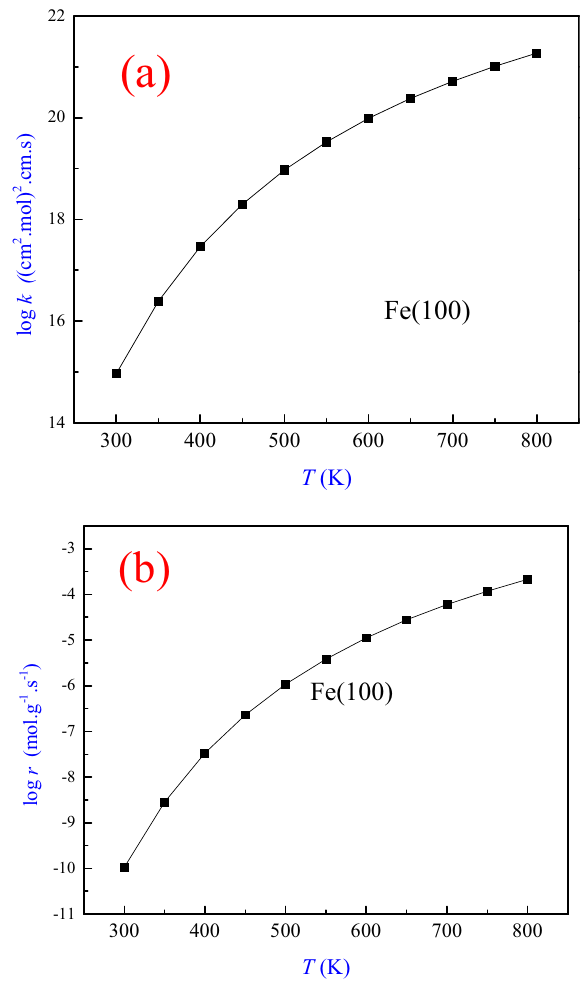
Figure 3: The reaction rate constant ( a ) and the reaction rate for the dissociative adsorption ( b ) of a chlorine molecule over the Fe ( 100 )